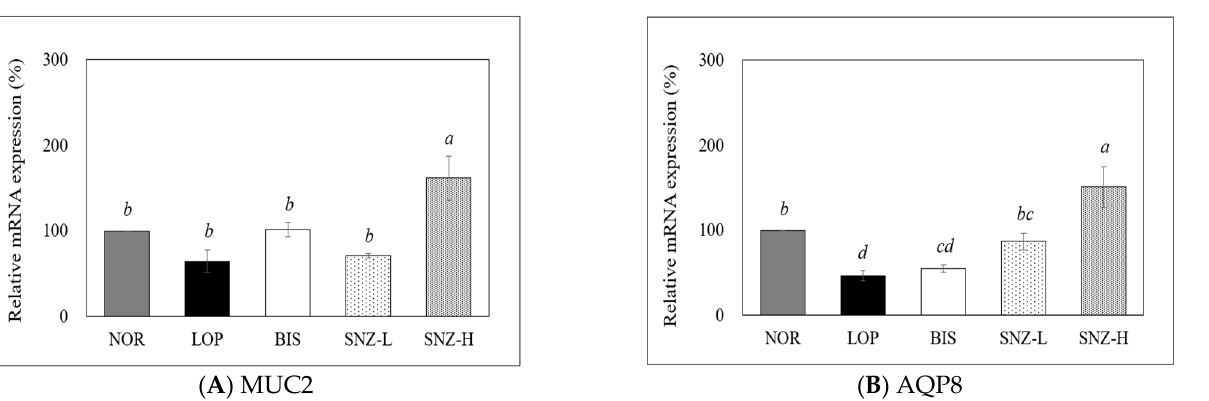
Figure 5. Effects of B. coagulans SNZ 1969 on mRNA expression of MUC2 ( A ) and AQP8 ( B ) in the transverse colon of loperamide-induced constipation rats. NOR: Normal group; LOP: Loperamide treated group; BIS: Loperamide and Bisacodyl 8 mg/kg treated group; SNZ-L: Loperamide and B. coagulans SNZ 1969 at 1 × 10 8 CFU/day treated group; SNZ-H: Loperamide and B. coagulans SNZ 1969 at 1 × 10 10 CFU/day treated group. Total mRNA was isolated by Tri-reagent and used for cDNA synthesis and real-time PCR. The GAPDH level was used for comparison as a loading control. The results were analyzed by the ∆∆ CT method, and statistical treatment was performed by repeating three times independently. The results are presented as mean ± SE (n = 8). Means with different letters above a bar are significantly different at p < 0.05 by Duncan’s multiple range